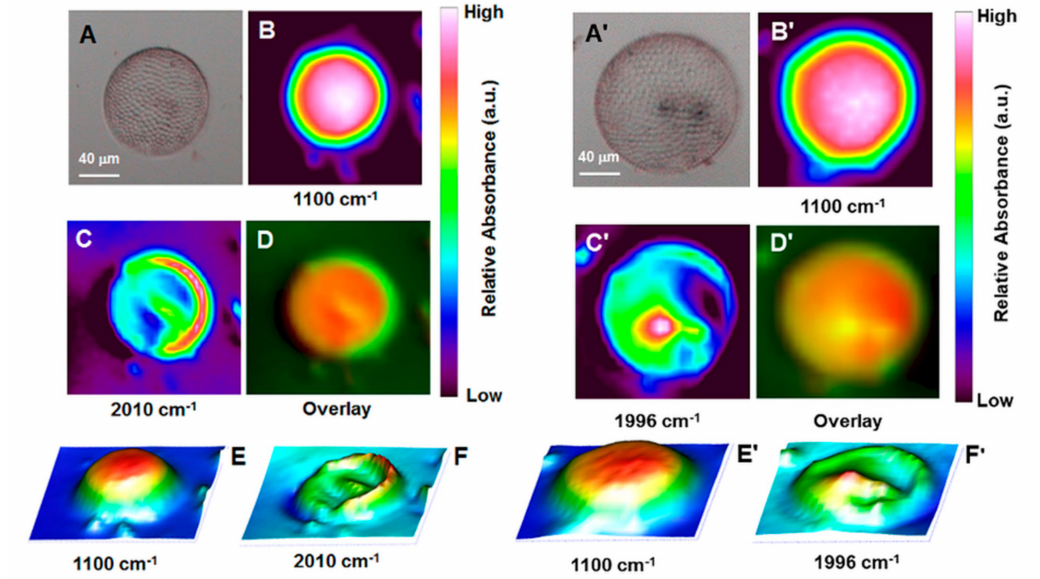
Figure 3. MCT detector generated chemical images of single Coscinodiscus valves exposed to CH 3 OH solutions of the CO releasing drugs B 12 -ReCORM-2 (left) and ReCORM-2 (right). ( A ) and ( A’ ): Optical image of single Coscinodiscus valve. ( B ) and ( B’ ): chemical mapping of the Si-O-Si stretching vibration at 1100 cm − 1 . ( C ) and ( C’ ): chemical mapping of the symmetric C ≡ O stretching mode of B 12 -ReCORM-2 at 2010 (left) and ReCORM-2 at 1996 (right) cm − 1 respectively. ( D ) and ( D’ ): overlay of ( B ) and ( C ), and ( B’ ) and ( C’ ) respectively. ( E ) and ( E’ ): 3D surface representations of chemical maps shown in ( B ) and ( B’ ) respectively. ( F ) and ( F’ ): 3D surface representations of chemical maps shown in ( C ) and ( C’ ) respectively. Images were recorded with frustules allowed to settle in a thin film of paratone oil on round CaF 2 windows (2 cm in diameter; 2 mm